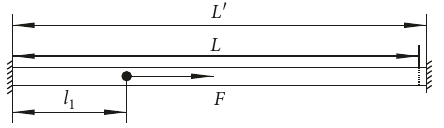
Figure 4: Simplified model of the ball screw.